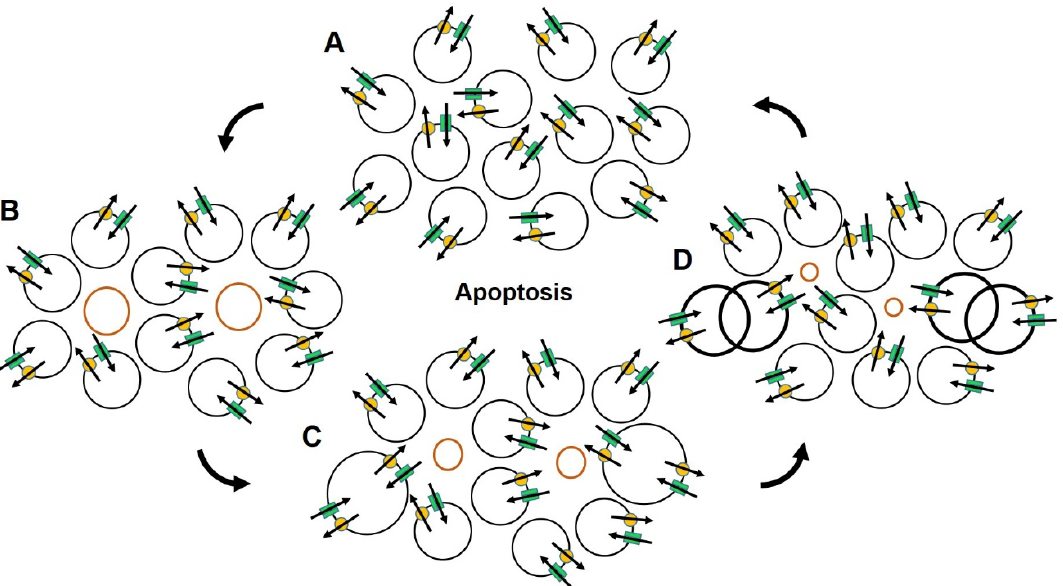
Figure 2. The illustration depicts important characteristics of normal apoptosis that rely on proper ion channel expression and function and are essential for maintaining healthy organ structure and integrity. The circular profiles represent relative size of normal cells (black circles) and cells scheduled for programmed cell death (red circles). Parallel green bars and yellow dots represent typical ion channels and their restorative mechanisms, here for Na + , respectively. Arrows denote the direction of ionic flow. Dividing cells are indicated by overlapping circles and bold lines. Beginning in ( A ), normal cells for a portion of functioning organ are rendered with relatively uniform size. As apoptosis begins ( B ), there is a shift in ion channel function in the cells scheduled for apoptotic death (red circles) resulting in a decrease in volume that progresses through ( C , D ) as the process continues. This process provides room for replacement cells seen dividing in ( D ). Upon completion of cell division, the remains of the dead cells are removed by phagocytosis maintaining structural integrity in ( A ), while renewing component cells. Note that this process occurs without initiating inflammation.